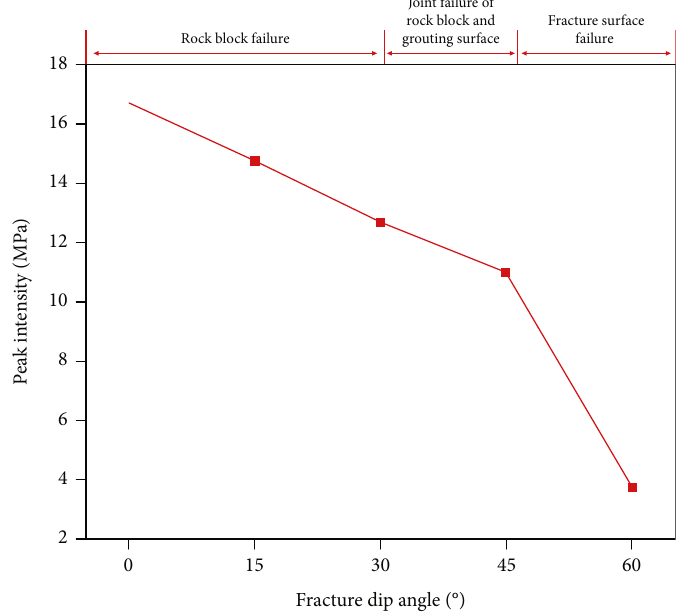
Figure 17: Variations in peak strengths of grouted specimens with the crack inclination